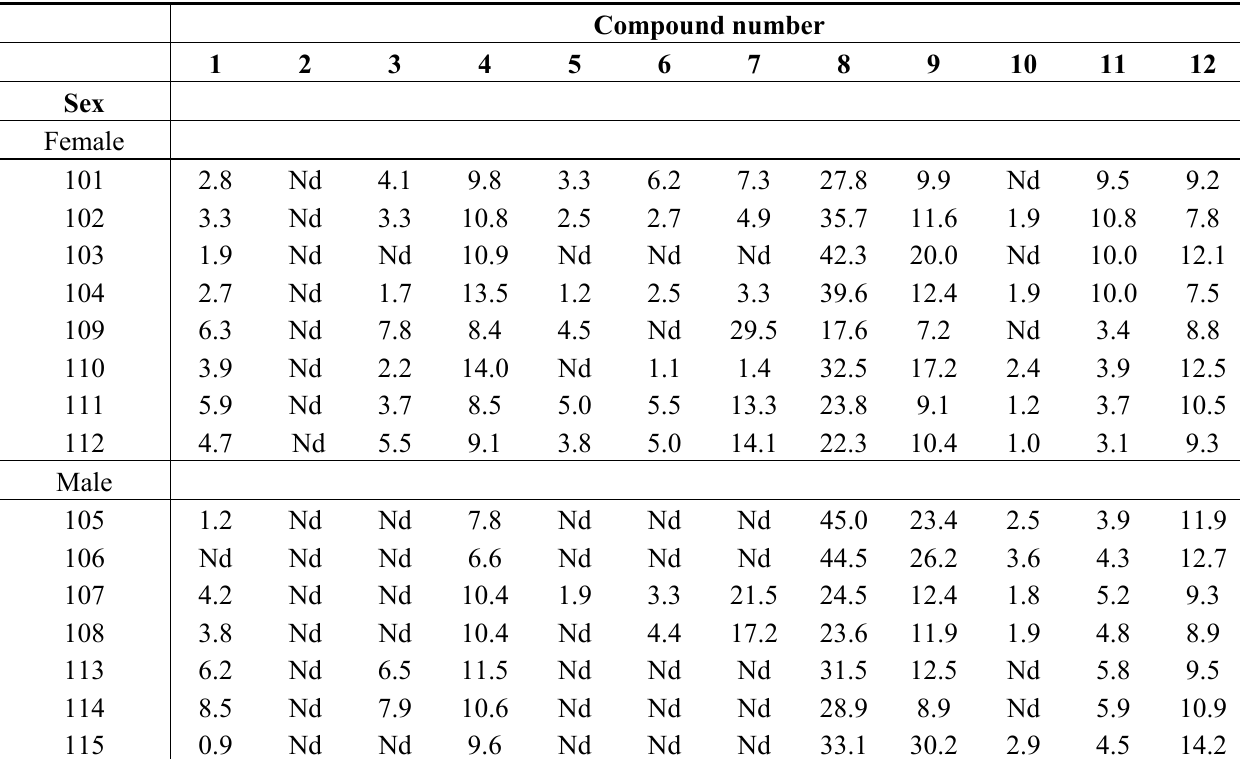
Table 2. Relative percent composition of the Austrocedrus chilensis resin diterpenes measured by GC-MS (as methyl esters). Samples collected in February 2011. Samples 101–104 and 109–112 are from female trees, 105–108 and 113–115 from male trees. Nd: not